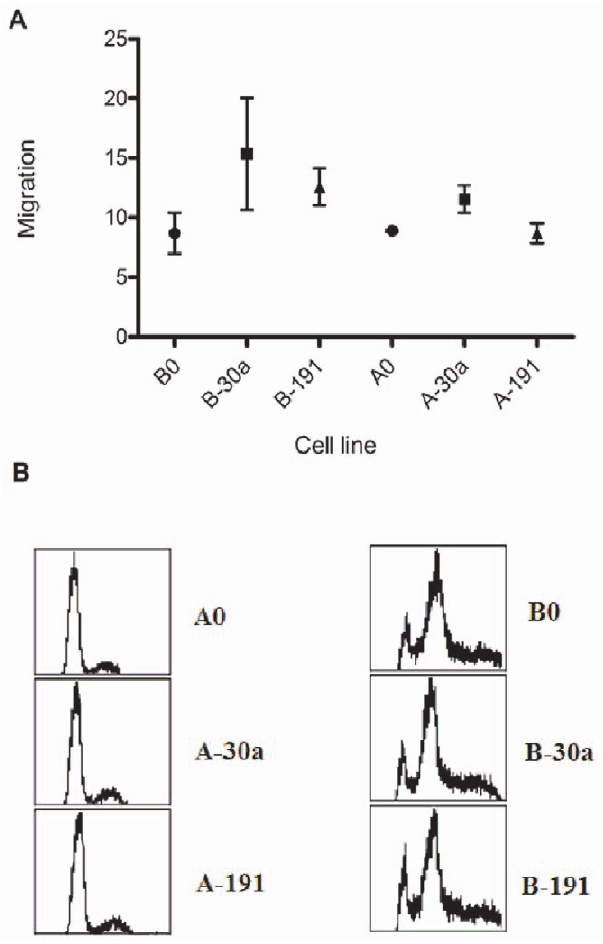
Figure 3. Analysis of migration and cell cycle with overexpres- sion of miR-30a and -191. A. Cell migration of A-30a and B-30a is increased compared to controls; no effect of overexpression of miR-191 is seen. B. Cell cycle analysis of stable transfectants demonstrating no difference between cells over-expressing miR-30a and -191 compared to